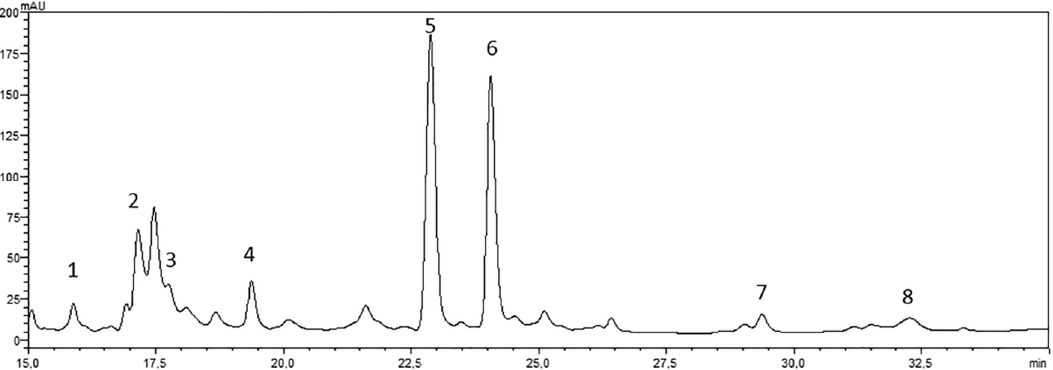
Figure 7. Reversed-phase high-performance liquid chromatography coupled with diode array detection (RP-HPLC-DAD) separation of flavonoids present in OJe. UV–Vis spectrum of the eluted molecules was monitored between 200 and 800 nm. The chromatogram was recorded at 278 nm. Flavonoids corresponding to peaks 1–7, expressed in milligrams (mg) per liter (L) of aqueous extract (mg/L), are the following: (1) lucenin-2 (6.2); (2) vicenin-2 (16.1); (3) lucenin-2-4 ′ -methyl ester (9.5); (4) eriocitrin (11.9); (5) narirutin (62.8); (6) hesperidin (56.4); (7) sinensetin (0.52); (8) nobiletin (5.29).